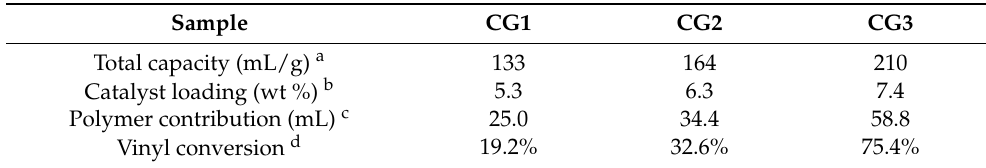
Table 4. (a) Capacities of compounded getters. (b) Pd loading of a compounded getter. (c) Polymer contribution to a compounded getter with a weight of 1.0 g. (d) Vinyl group conversion in each compounded getter.